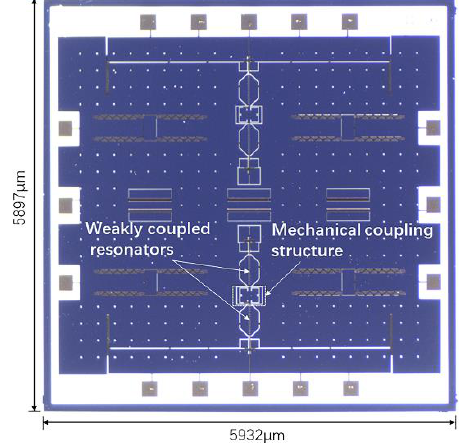
Figure 6. Photograph of mode-localized accelerometer.